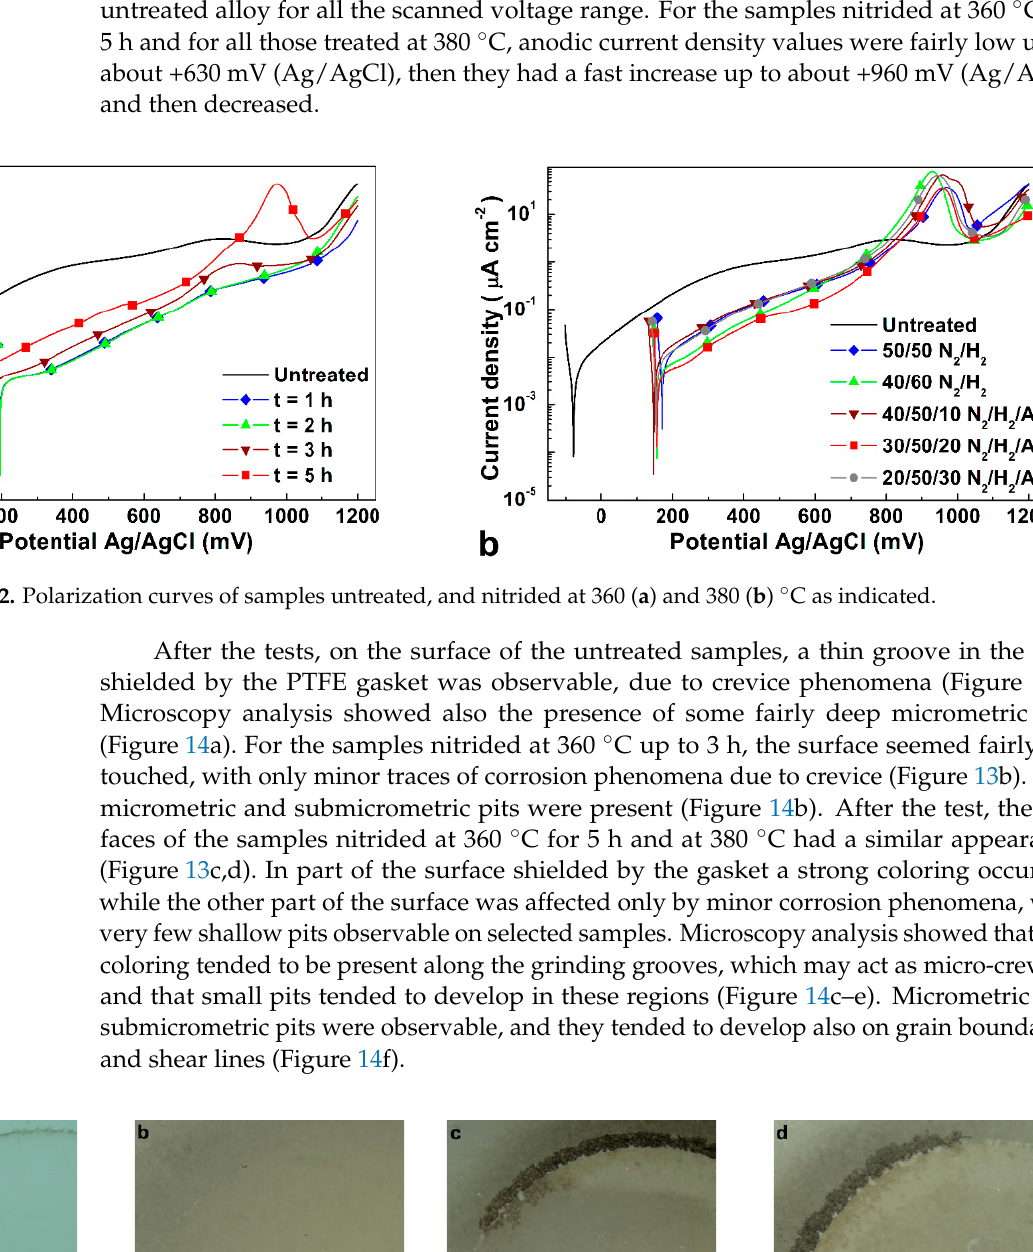
Figure 14. Micrographs of the surface morphology after the potentiodynamic tests of samples untreated ( a ), nitrided at 360 °C, 50 vol.% N 2 + 50 vol.% H 2 , for 1 ( b ) and 5 ( c ) h, and at 380 °C, 50 vol.% N 2 + 50 vol.% H 2 , for 3 h ( d – f ). 4. Discussion Low-temperature nitriding is an effective method for increasing surface hardness of austenitic stainless steels, maintaining or even improving their corrosion resistance. As reported in our previous papers [27,36] and by other authors [28,47,48], the choice of treat- ment parameters is strictly connected with the steel composition in order to avoid the precipitation of large amounts of nitrides, which are able to improve surface hardness, but cause a worsening of corrosion resistance. High manganese-containing austenitic stainless